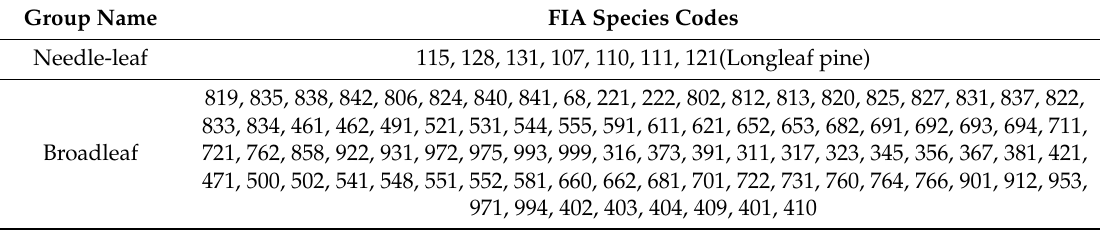
Table A2. Groups of trees species used in this study based on FIA tree species codes [24]. Group Name